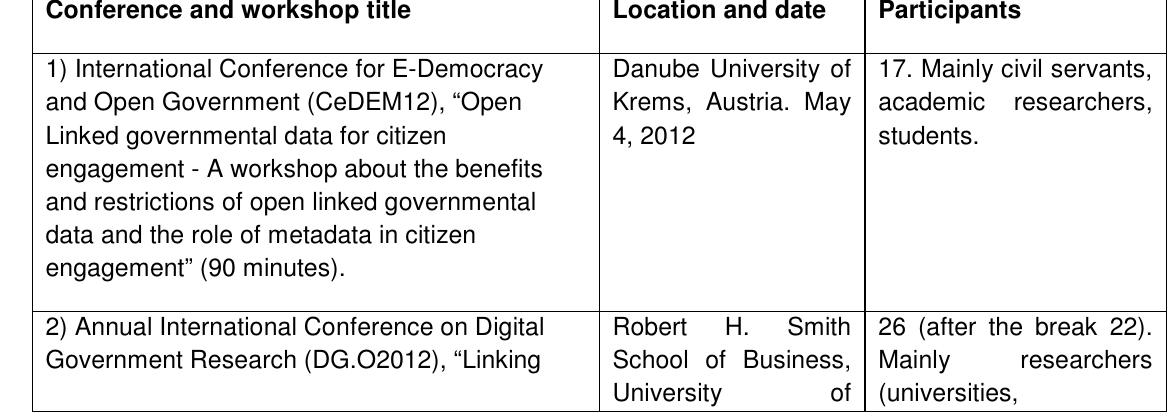
Table 1: Organized workshops to obtain information about metadata benefits and requirements for the open data